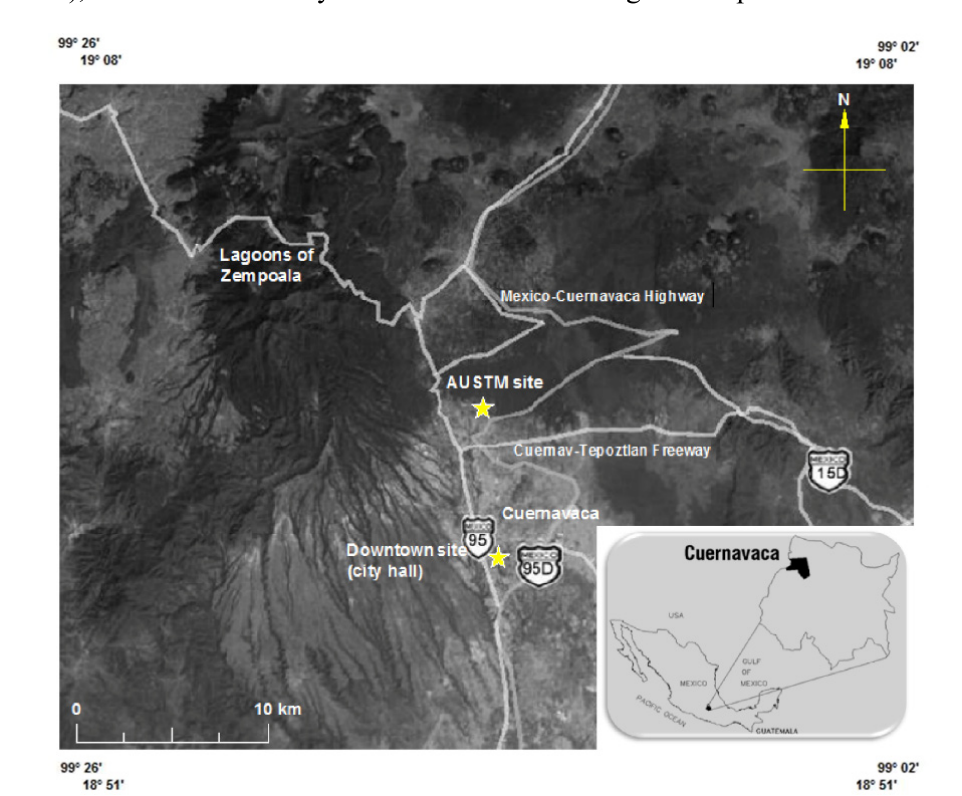
Figure 2. Sampling sites at the city of Cuernavaca,